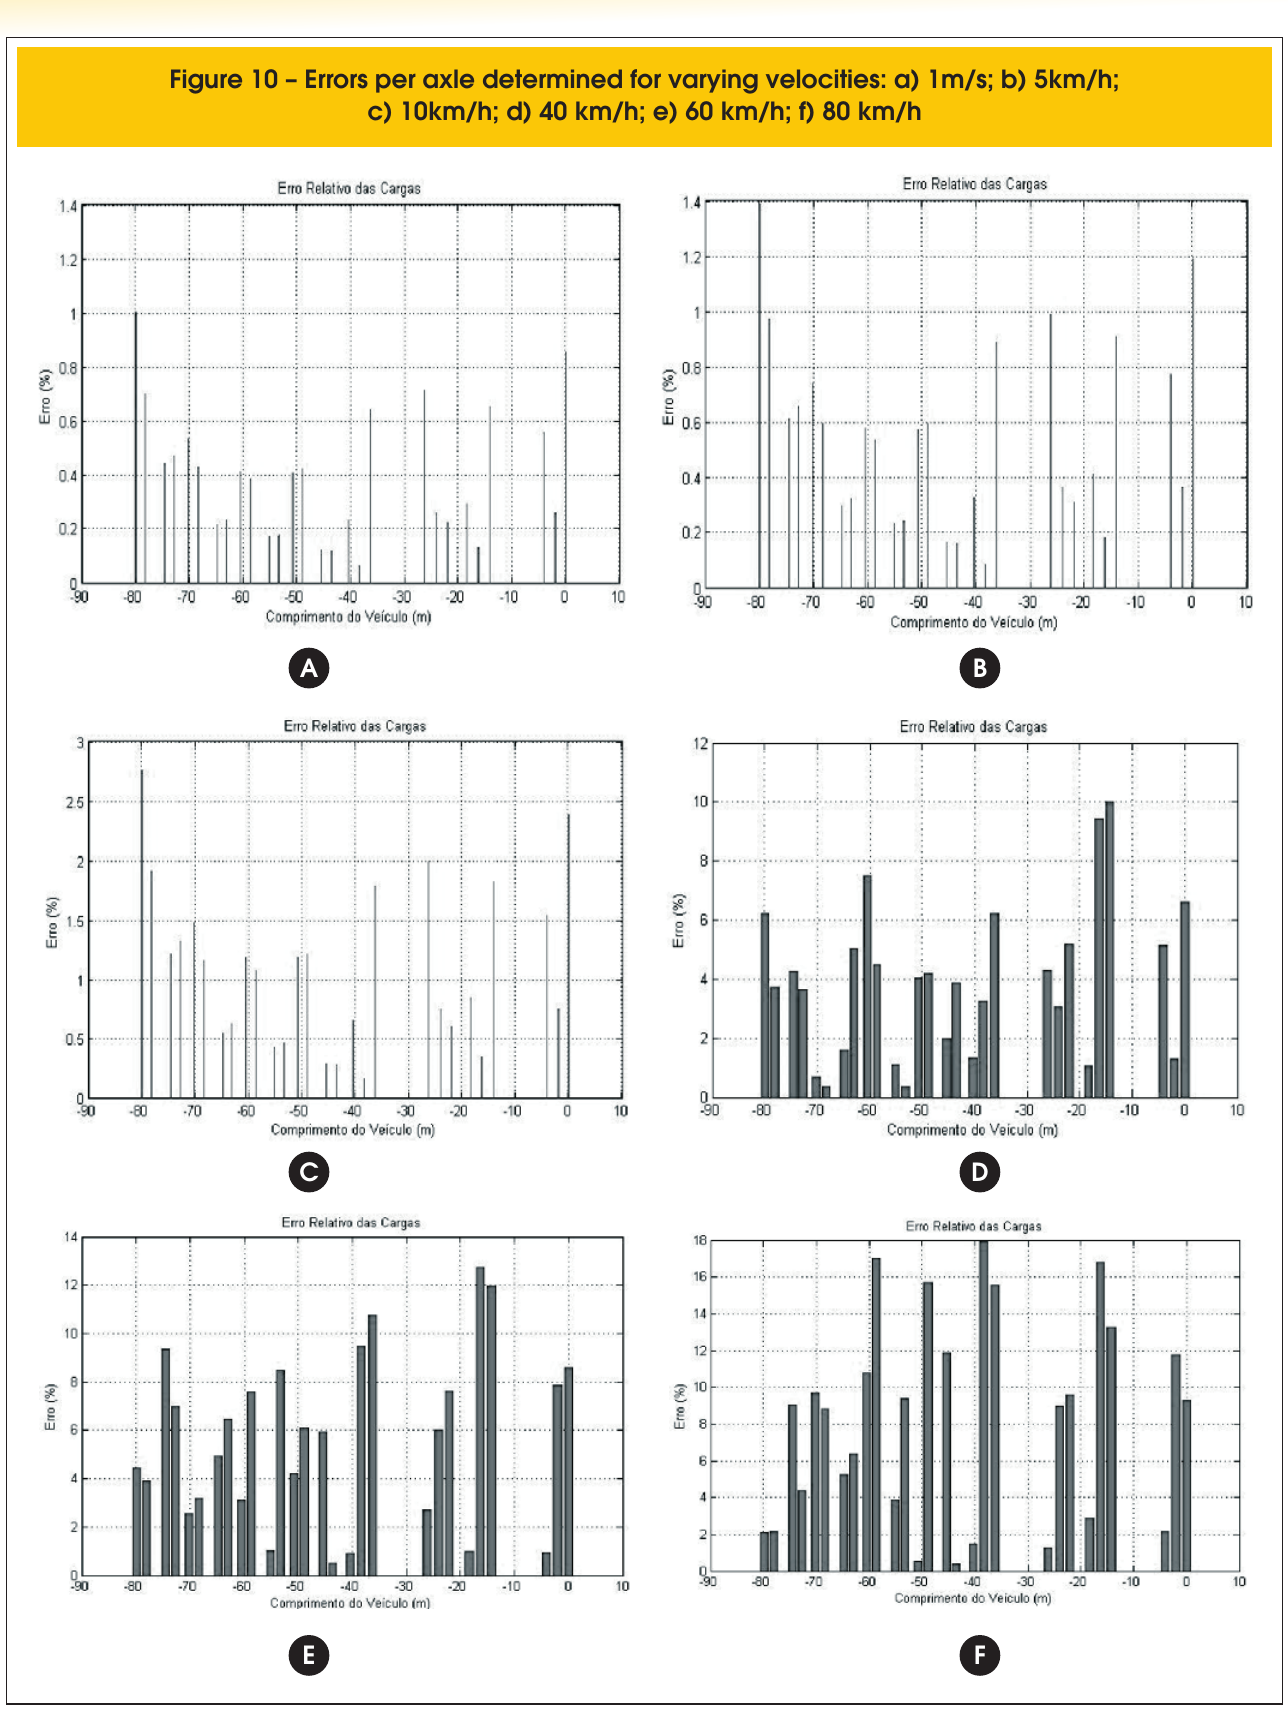
Figure 10 – Errors per axle determined for varying velocities: a) 1m/s; b)